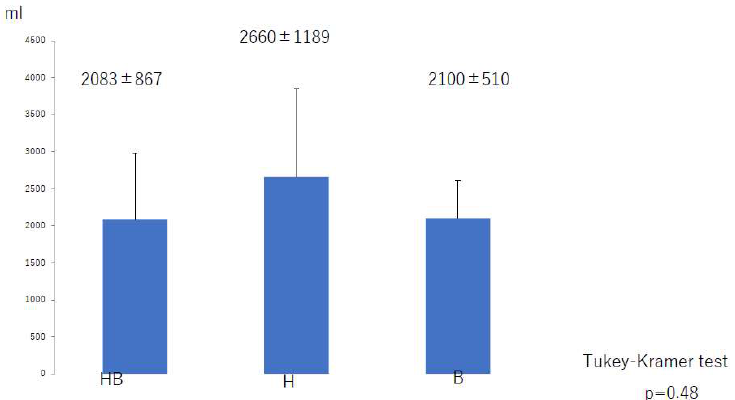
Figure 8. Total liposuction volume according to type of postoperative compression strategy. B, bandage only; SB, compression stocking and bandage; S, stocking only.